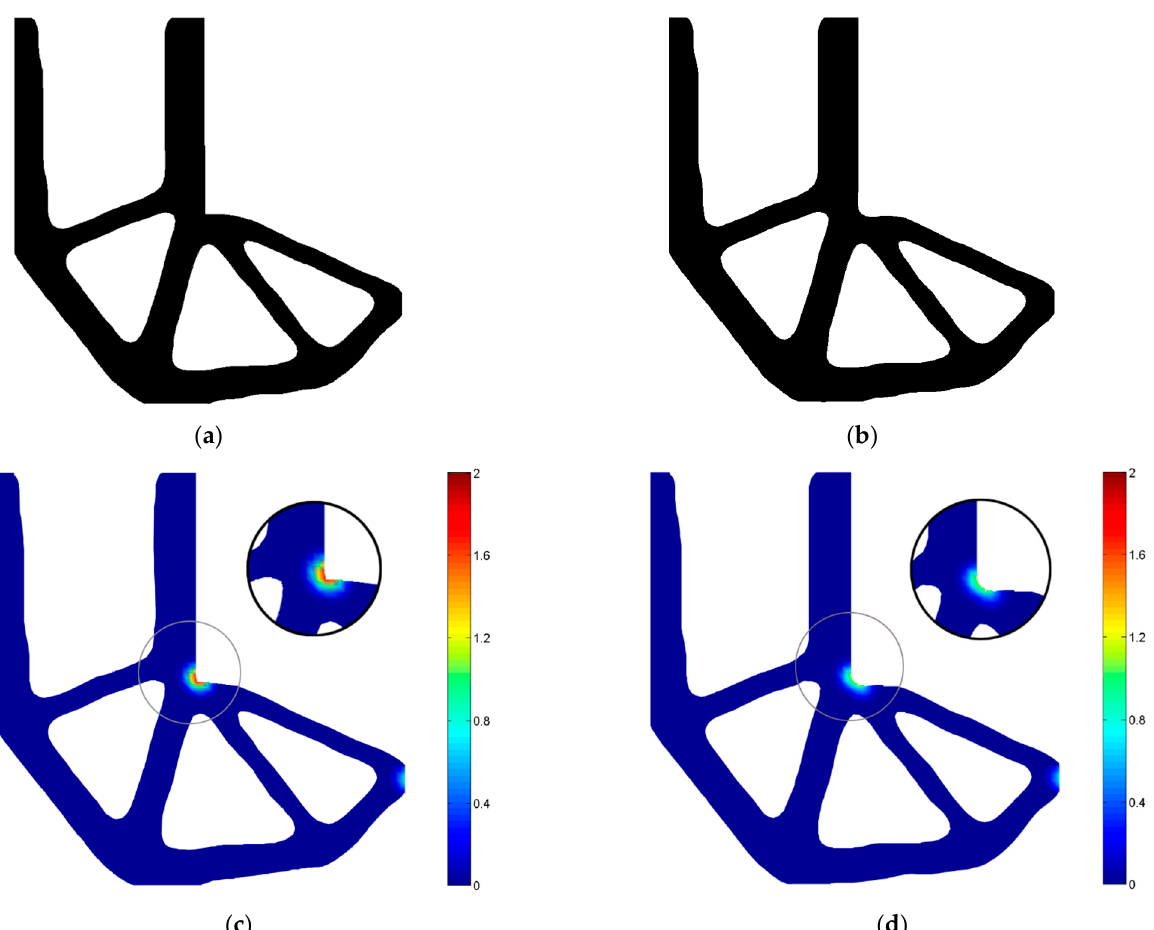
Figure 6. Convergence history of L-shaped beam considering porosity constraint.